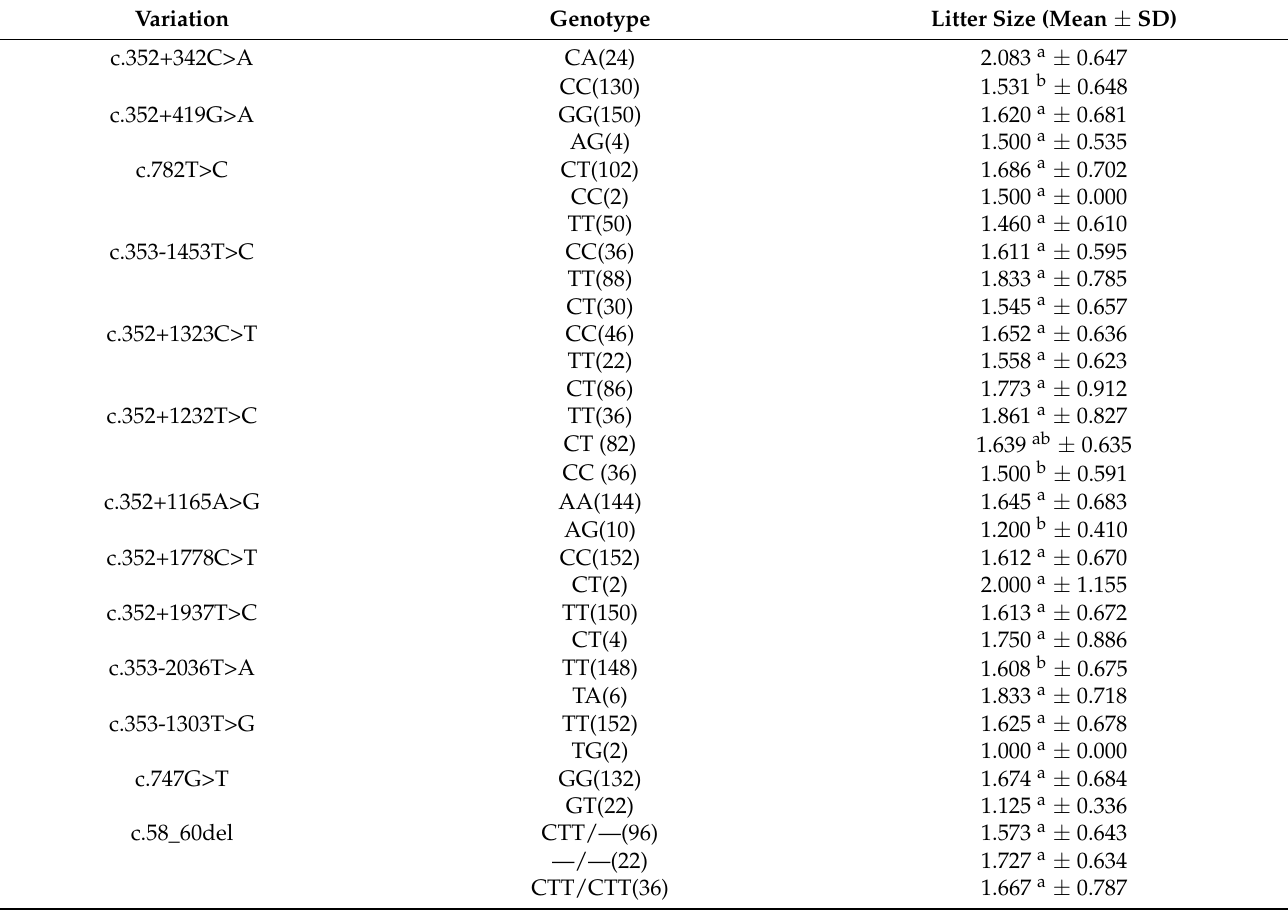
Table 4. Least-square means and standard errors of litter size for different genotypes in Luzhong ewes. Variation